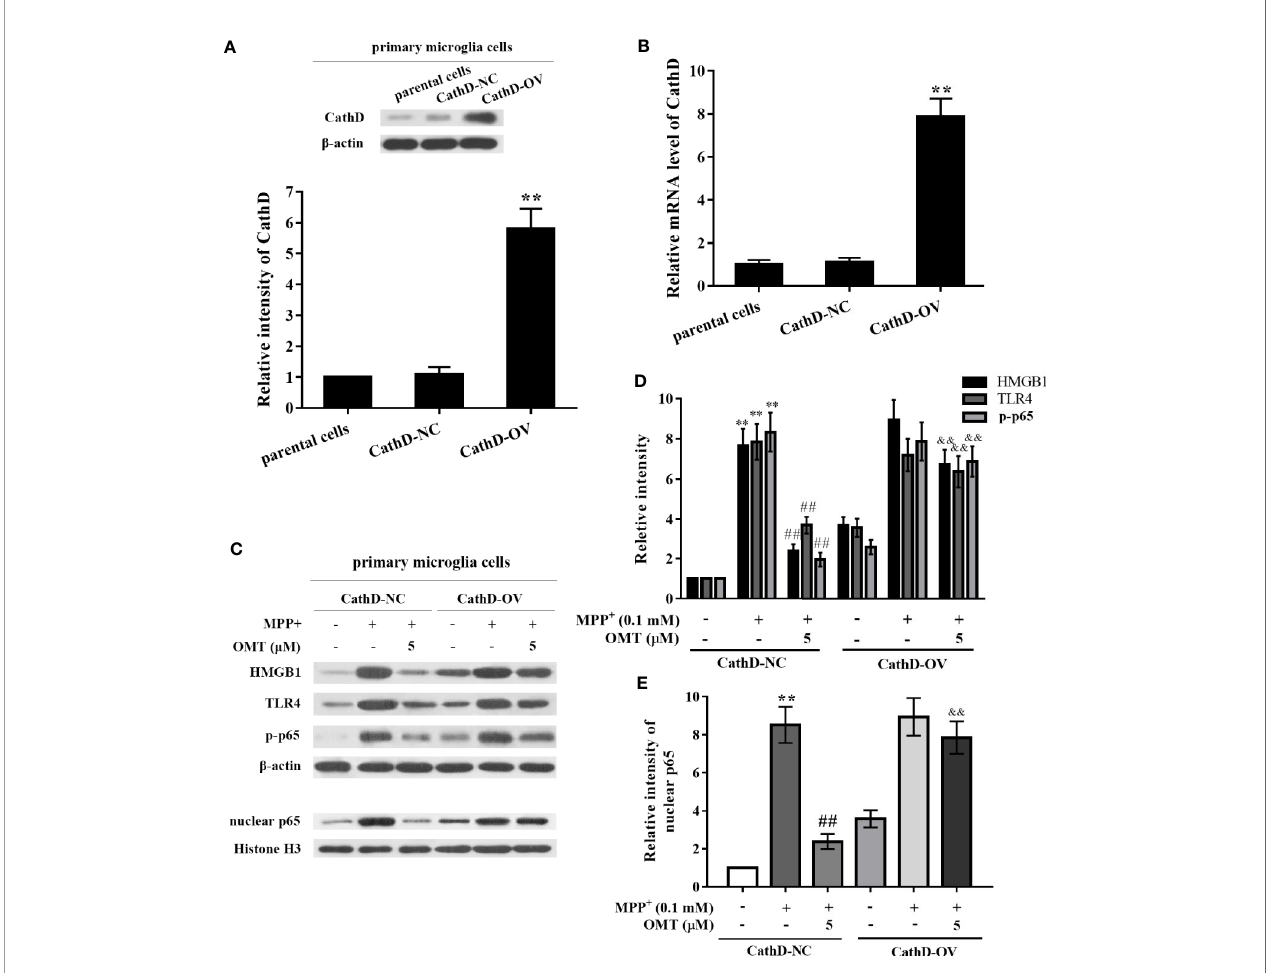
FIGURE 5 | OMT inhibited HMGB1/TLR4/NF- k B signaling pathway through down-regulation of CathD in MPP + -induced primary microglia. Mice primary microglia cells were infected with negative control lentiviral particles (CathD-NC) or lentiviral particles overexpressing CathD (CathD-OV). The mRNA and protein levels of CathD were determined by Western blot (A) and real-time RT-PCR (B) analysis. Twenty-four hours later, cells were pretreated with 0.1 mM MPP + and incubated for 6 h, followed by treatment with 5 m M OMT for another 24 h. (C – E) The activation of HMGB1/TLR4/NF- k B signaling pathway after overexpression of CathD was tested by Western blot analysis in MPP + -induced primary microglia cells. The data are presented as mean ± SEM. **p < 0.01 vs. CathD-NC cells; ## p < 0.01 vs. MPP + -treated CathD-NC cells; && p < 0.01 vs. MPP + - and OMT-treated CathD-NC cells. Student ’ s t